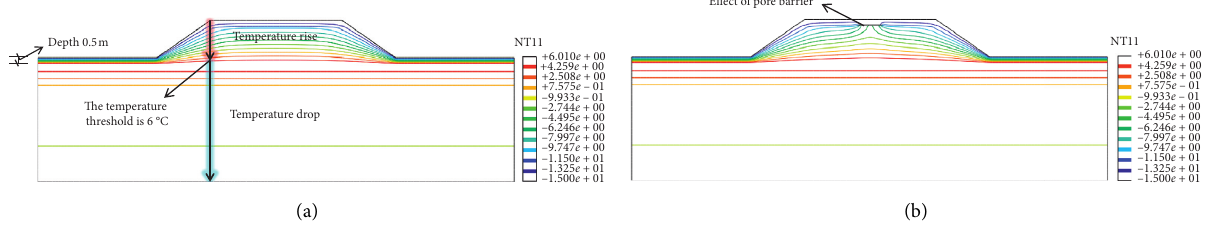
Figure 11: Initial temperature field distribution (a) without void damage and (b) with void damage.